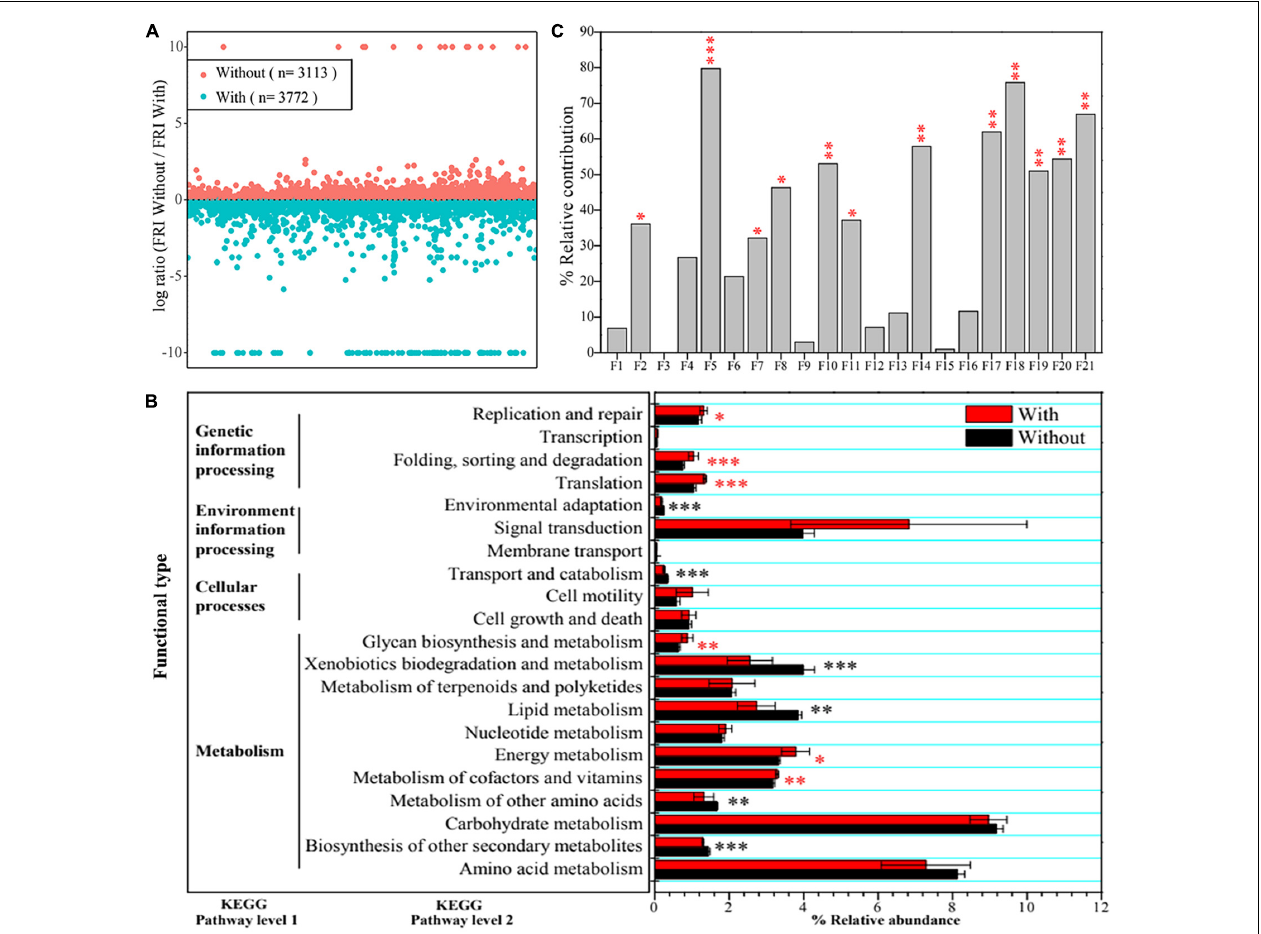
FIGURE 3 | Community functional differences and functional contributions to vegetation property. (A) Functional redundancy indices (FRIs) of bacterial community in soils with inoculation of phosphate-solubilizing bacteria (PSBs) (Sup + Bac) and soils without addition of PSBs (CK + Tri) soils. A log ratio > 0 denotes that a function is more redundant in soils without PSB addition. (B) Differences in bacterial functions between group with addition of PSBs (Sup + Bac) and group without addition of phosphorus-solubilizing bacteria (CK + Tri) at Kyoto Encyclopedia of Genes and Genomes (KEGG) pathway level 1 and level 2. (C) Effects of functions at KEGG pathway level 2 on vegetation property determined by permutational multivariate analysis of variance (PERMANOVA). The abbreviations of F1–F21 represent functions in panel B (from bottom to up, namely, from amino acid metabolism to replication and repair). Asterisks denote significance ( ∗ p < 0.05; ∗∗ p < 0.01; ∗∗∗ p <